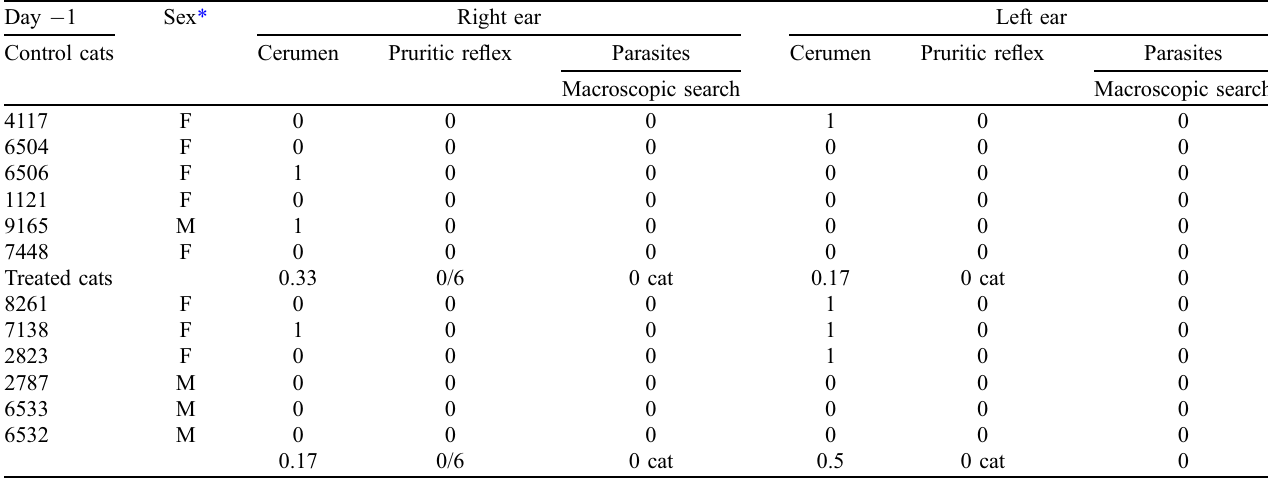
Table 3. Status of the control and treated cats at the beginning of the